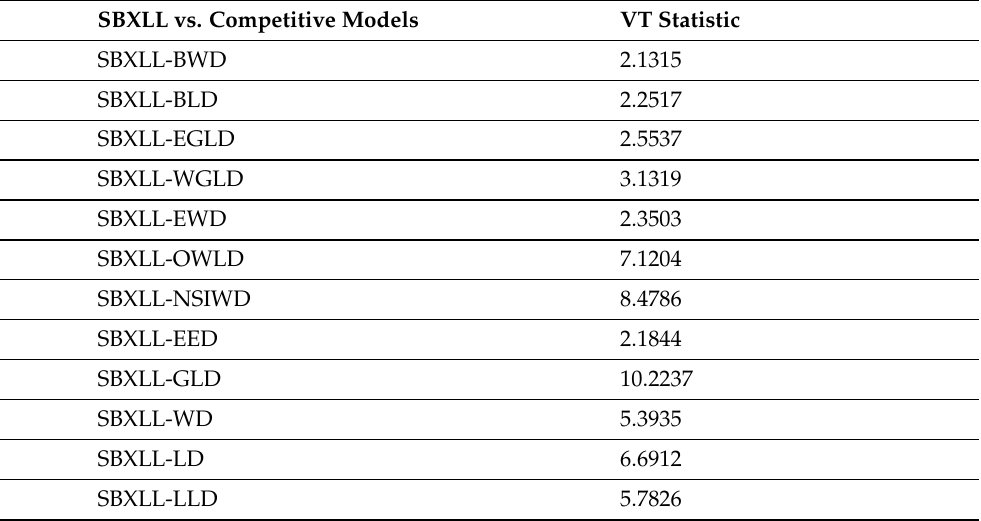
Table 30. Vuong’s test applied for the SBXLL model on data set V at Z 0.05 = 1.6495. SBXLL vs. Competitive